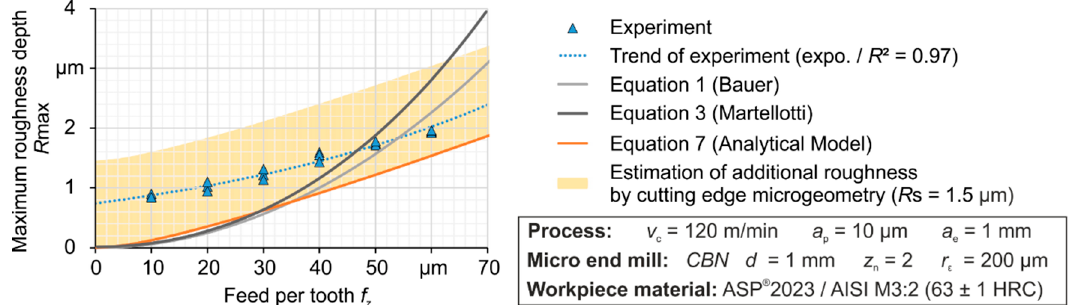
Figure 10. Validation of the analytical model and comparison to the models of Bauer and Martellotti.